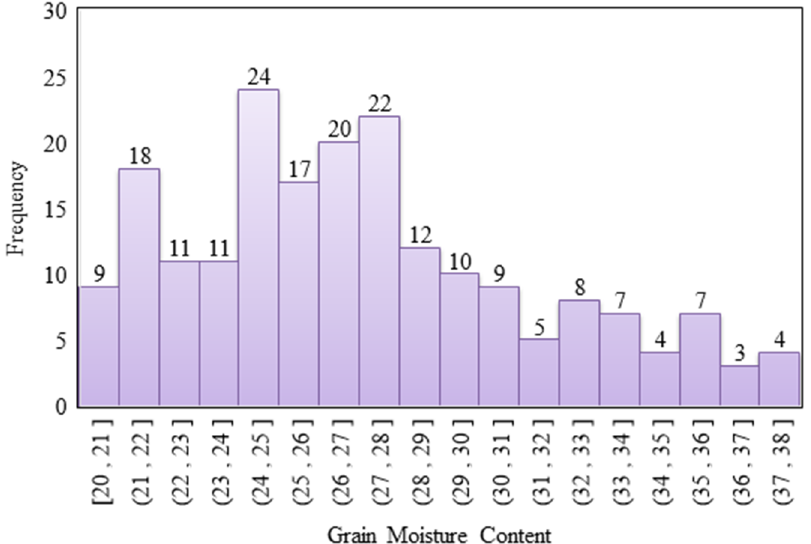
Figure 12. GMC distribution of the decline mode (N = 201).